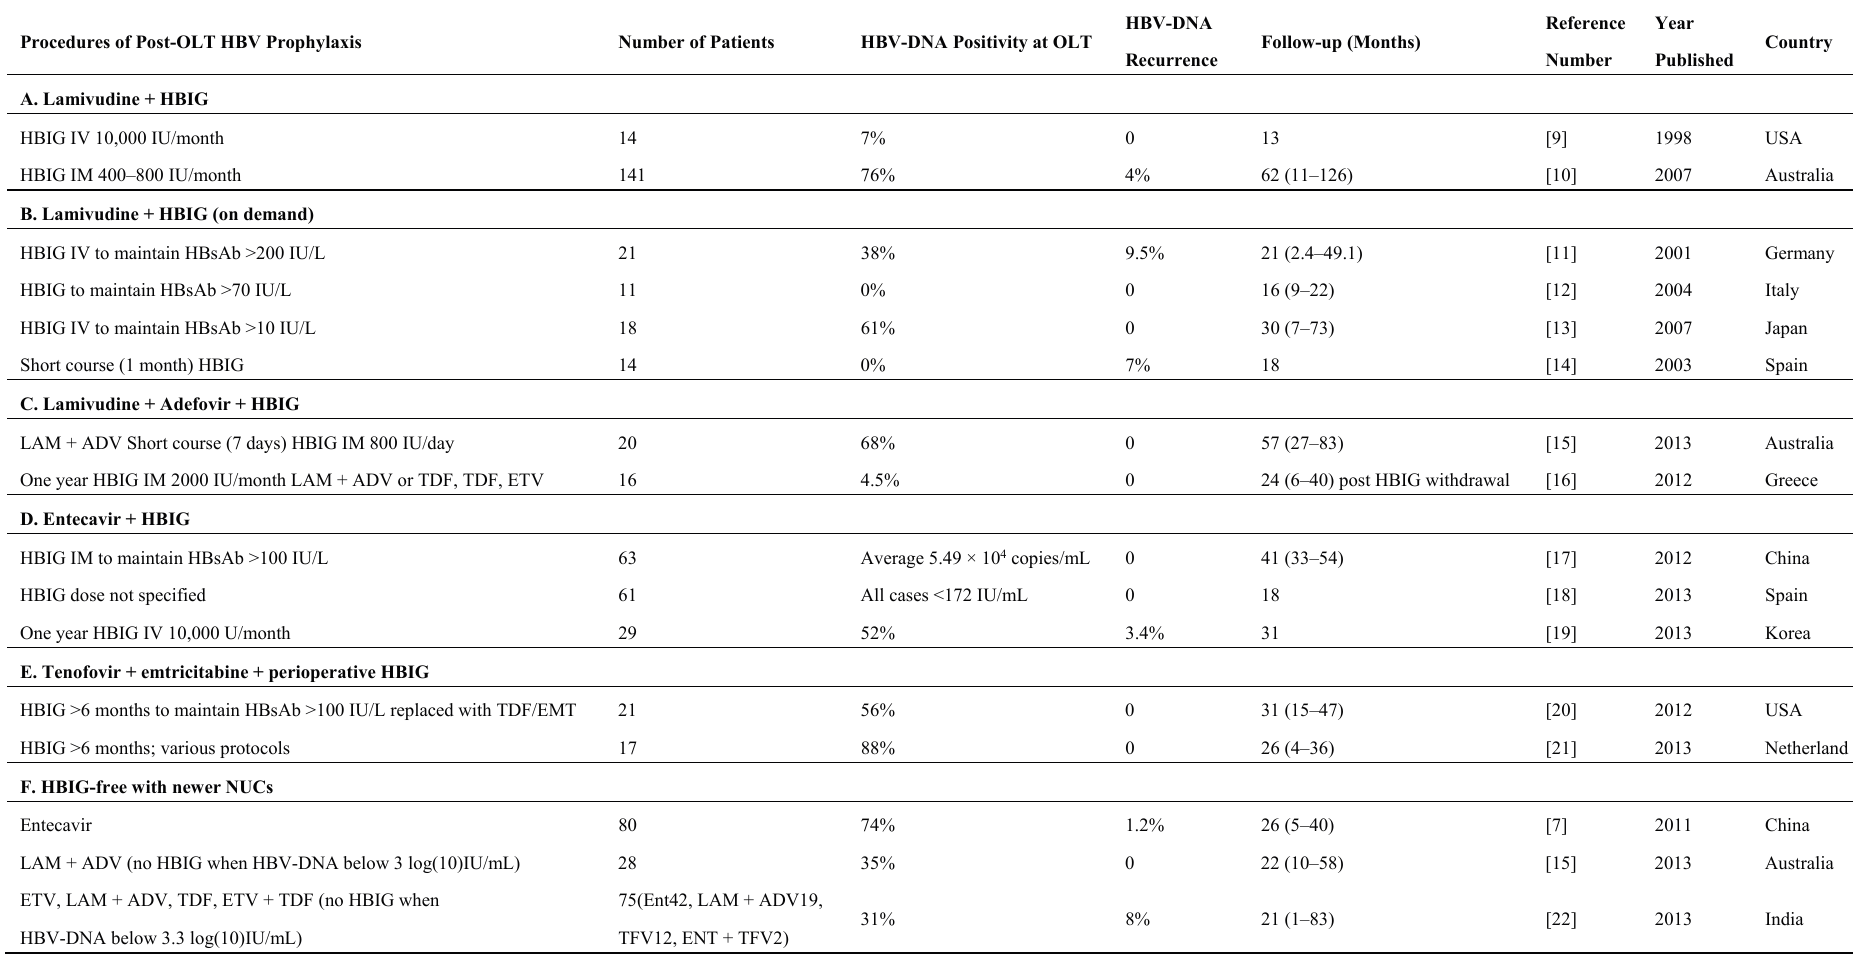
Table 1. Representative Post-OLT HBV Prophylaxis with NA and/or